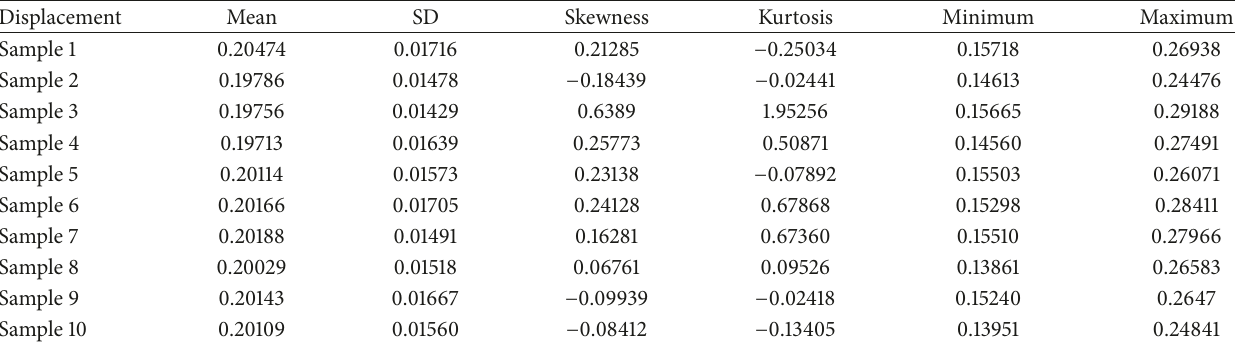
Table 20: Statistics of 10 samples parameters of low tower in the system top node 874# Ux displacement time history under wind field 2